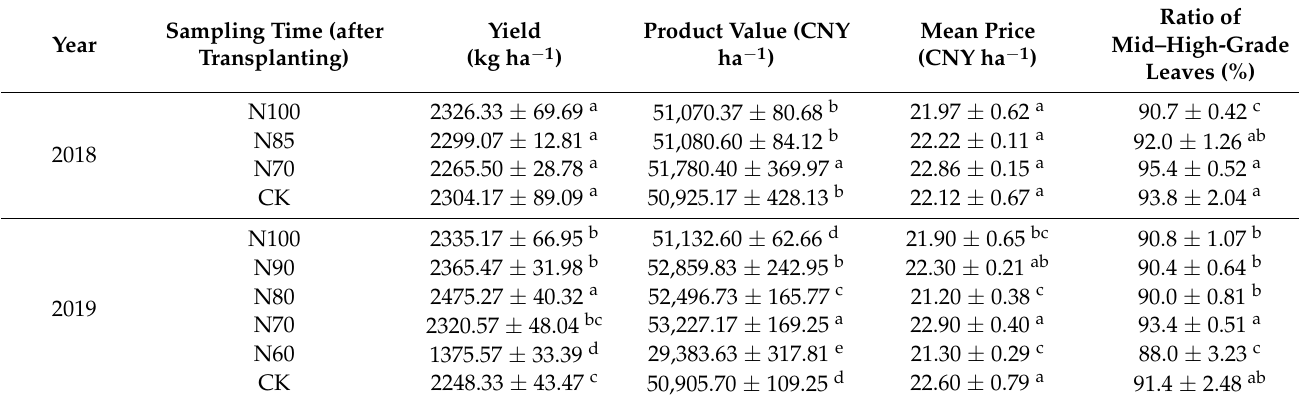
Table 7. Economic properties of tobacco leaves after